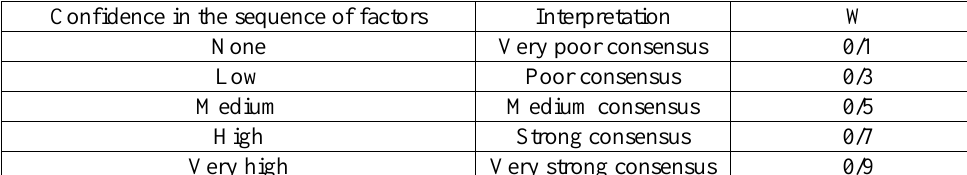
Table 6. Interpretation of Different Values of Kendall’s